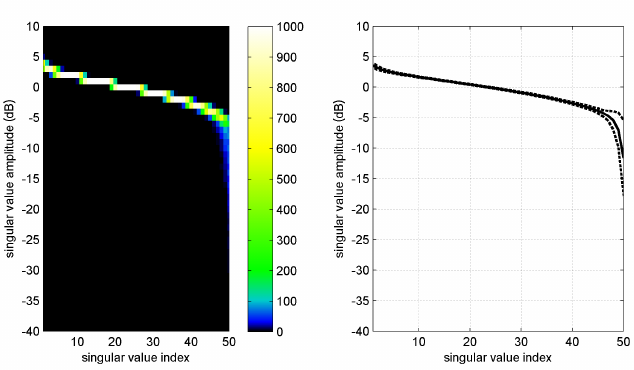
Figure 14. Distribution of the condition number as a function of the average distance d for K = 50 and the sparse array with α 1 = − 0.03. Each column of the matrix in the image map is a histogram of the condition number.